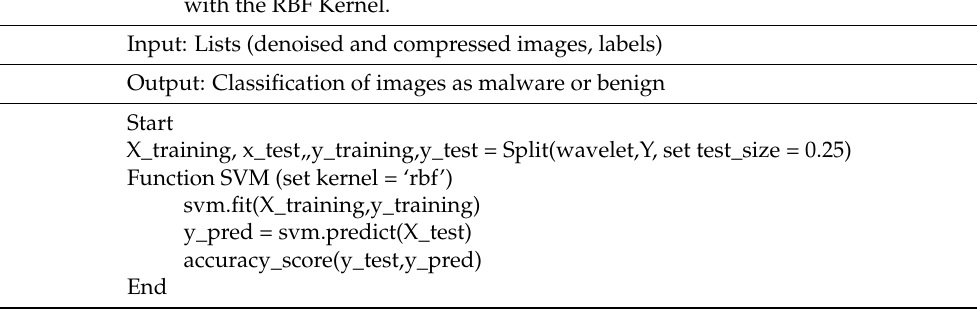
Table 5. Pseudocode of the algorithm used in the proposed methods to split the data and feed it into SVM with RBF kernel classifier. Algorithm 4: Distribute the dataset into training and testing, and feed it into the SVM with the RBF Kernel.